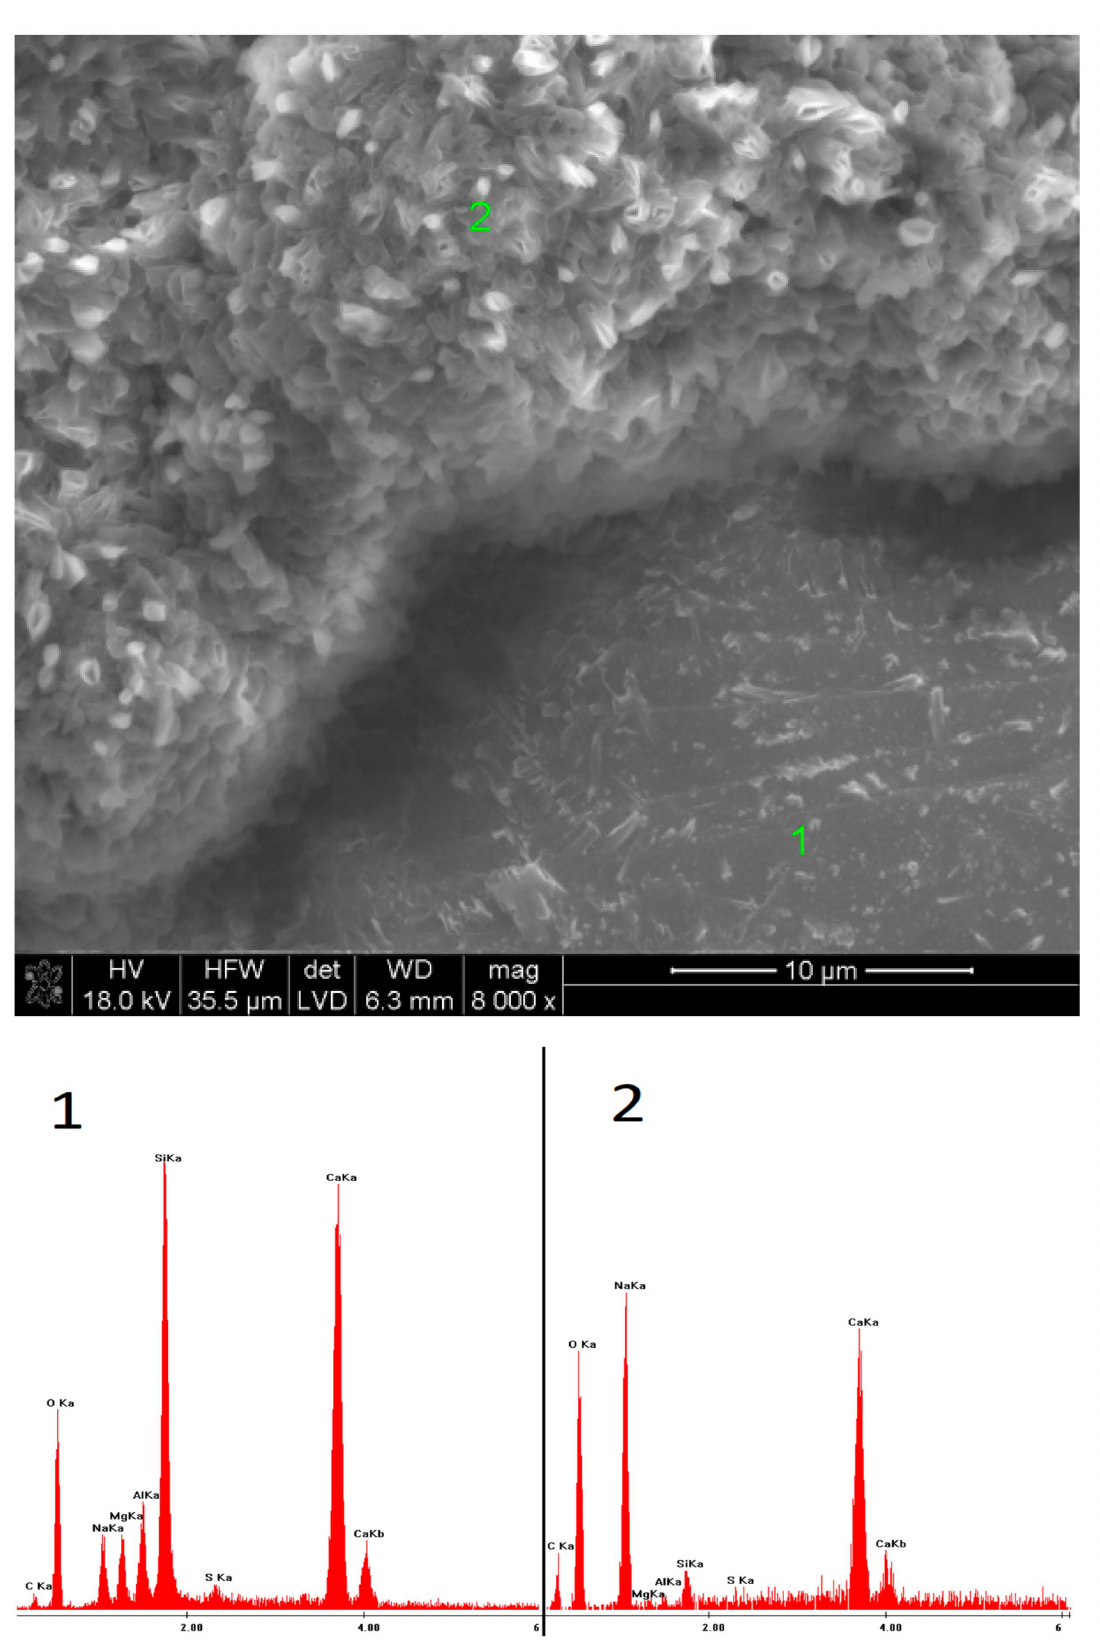
Figure 9. Microstructure of slag paste activated with sodium hydroxide after 40 days of curing—SEM + EDS; 1 —hydration products; 2 —unreacted slag